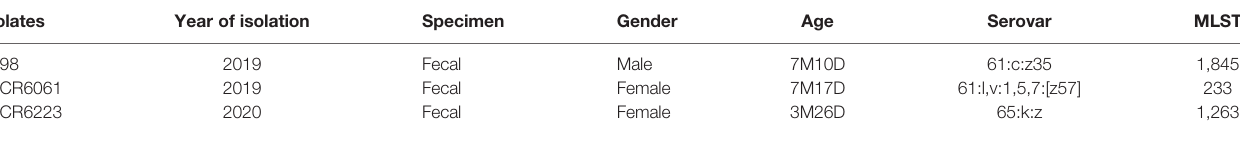
TABLE 1 | Source of isolates and molecular epidemiology of S. enterica subsp. diarizonae .